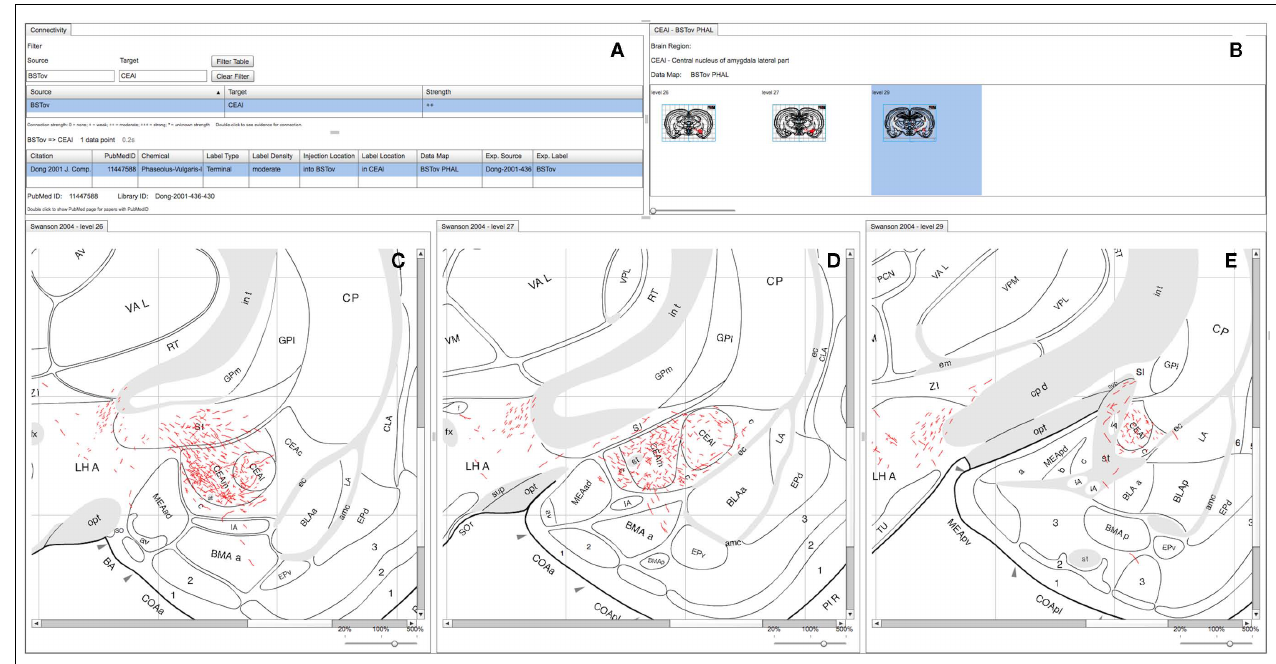
Map for the BSTov PHAL case limited to levels where CEAl can be found. (C) Level 26 of (Swanson, 1998) with BSTov PHAL data overlaid. (D) Level 27 of (Swanson, 1998) with BSTov PHAL data overlaid. (E) Level 29 of (Swanson, 1998) with BSTov PHAL data overlaid. Note, due to its time-consuming nature, data mapping generally cannot be performed on every available